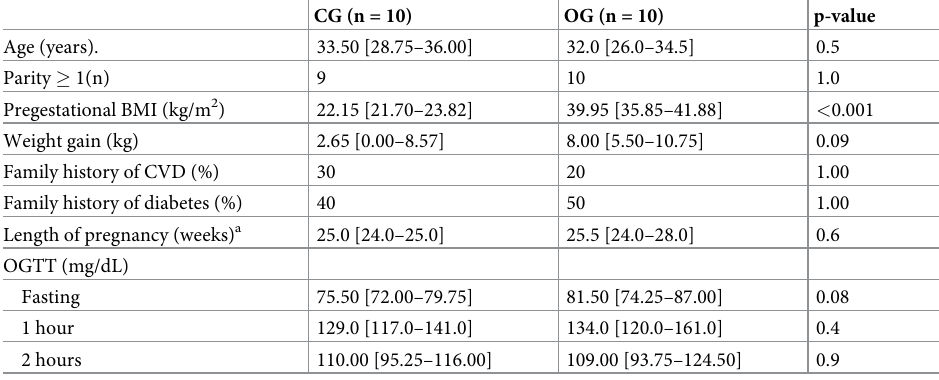
Table 1. Characteristics of pregnant women in the obese and control groups.